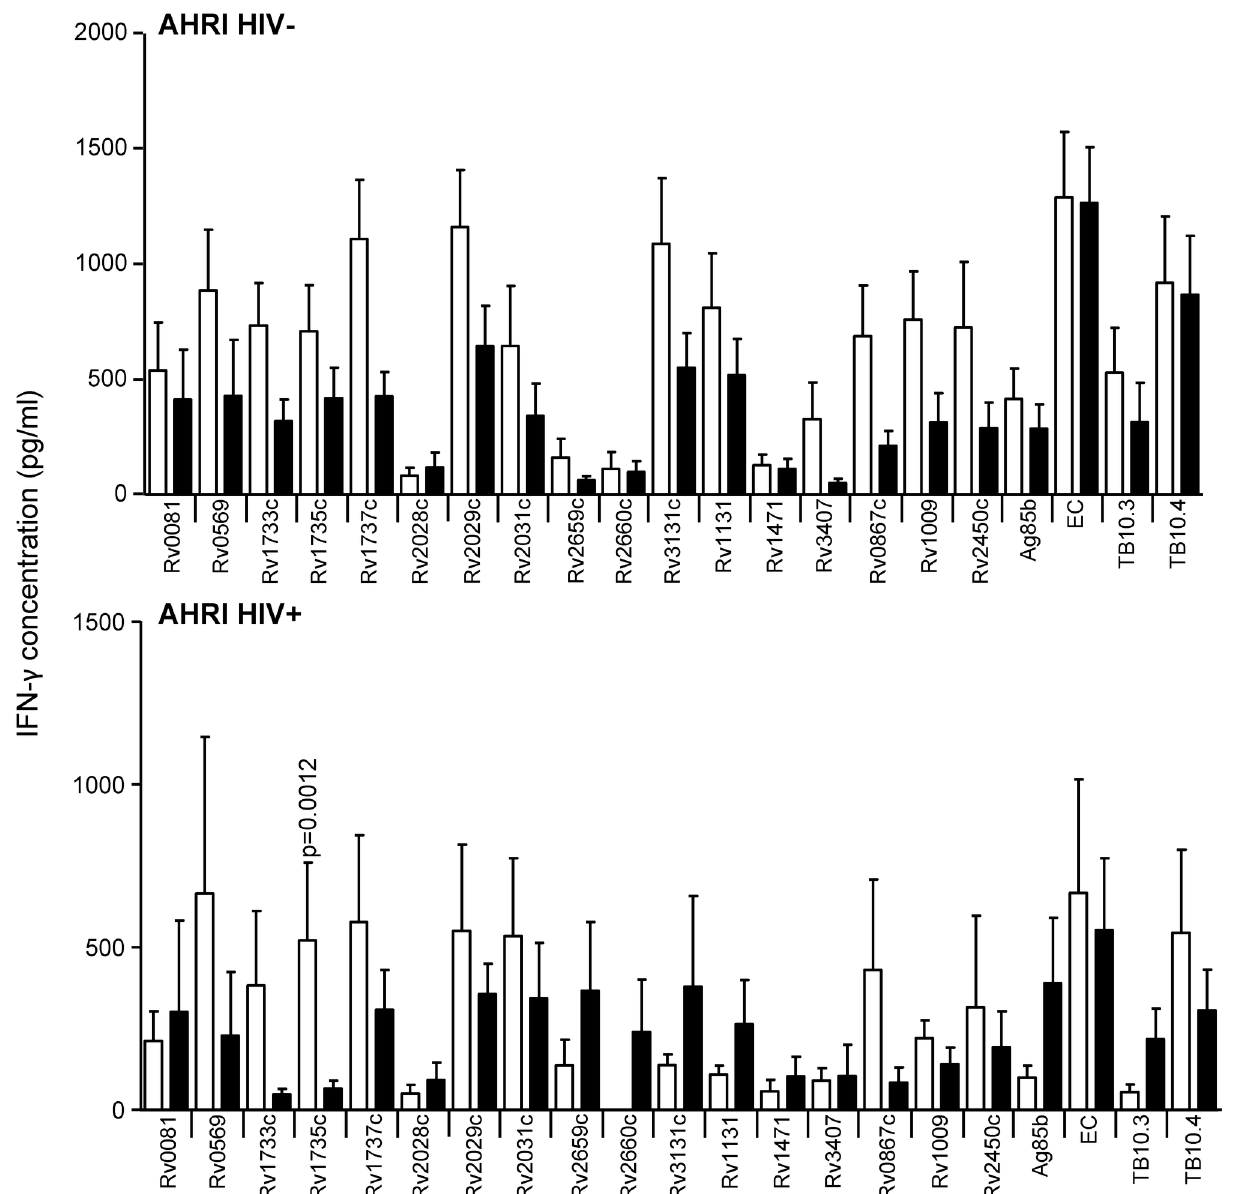
Figure 3. IFN-γ secretion in response to secreted, latent, and reactivation Mtb antigens in active TB and LTBI subjects, from Ethiopia. IFN-γ ELISA was performed on supernatants collected after 7 day antigen stimulation of diluted blood from TB cases (black) and TST + (LTBI) controls (white) from AHRI (Ethiopia). Line indicates median, whiskers indicate 5–95% range and dots indicate outliers. Data were analysed by Mann-Whitney U-test for HIV – and/or HIV + subjects. Significant differences are